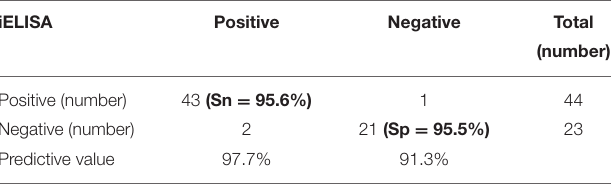
TABLE 5 | Diagnostic sensitivity (Sn) and specificity (Sp) of the RBD protein iELISA for detecting SARS-CoV-2-specific antibodies in the cat serum samples. iELISA Positive Negative Total